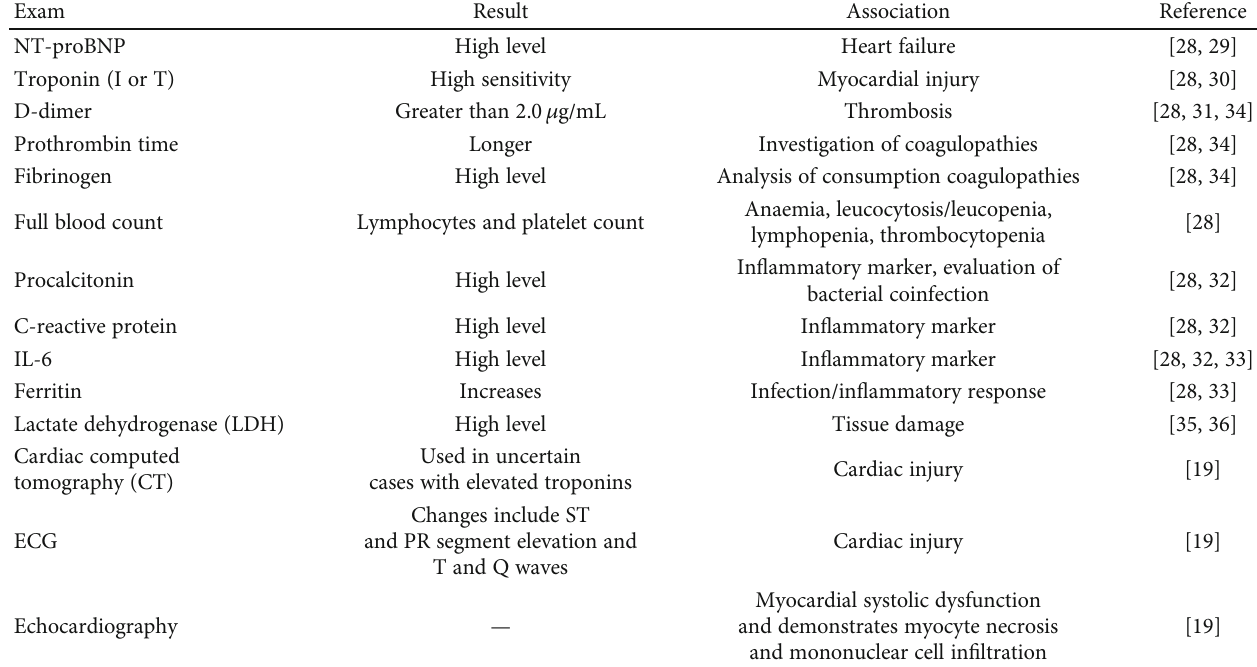
Table 1: Cardiological fi ndings related to disease severity and